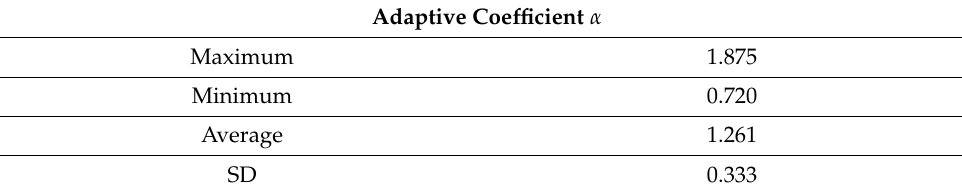
Table 7. Summary of the adaptive coefficient.